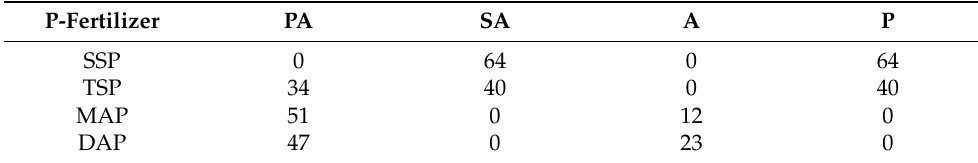
Table 3. Raw materials composition (%) for the different P-fertilizers.